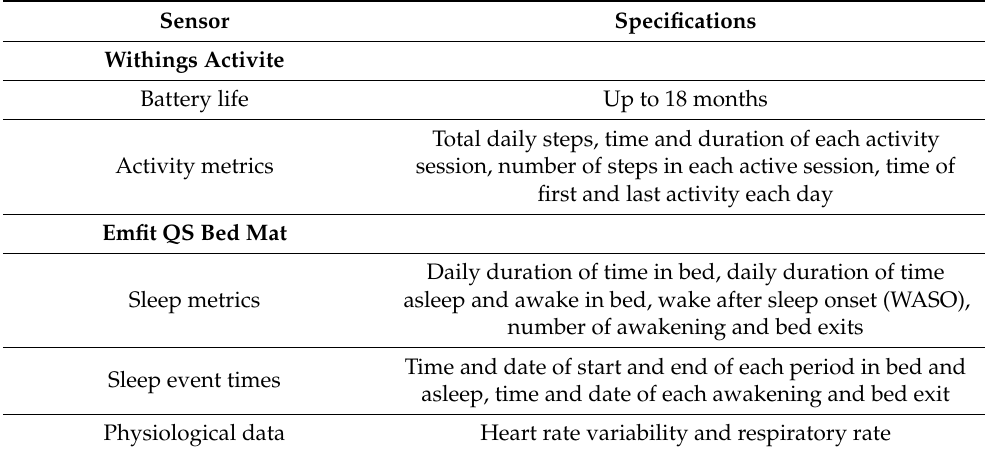
Table 2. Sensor specifications for activity and sleep/time in